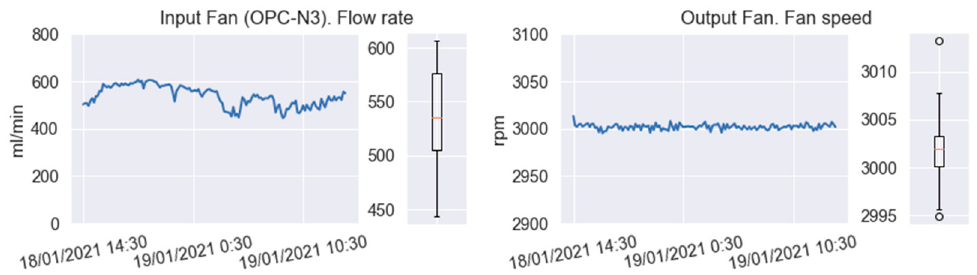
Figure 7. OPC-N3 inlet and outlet fans of the air manifold.